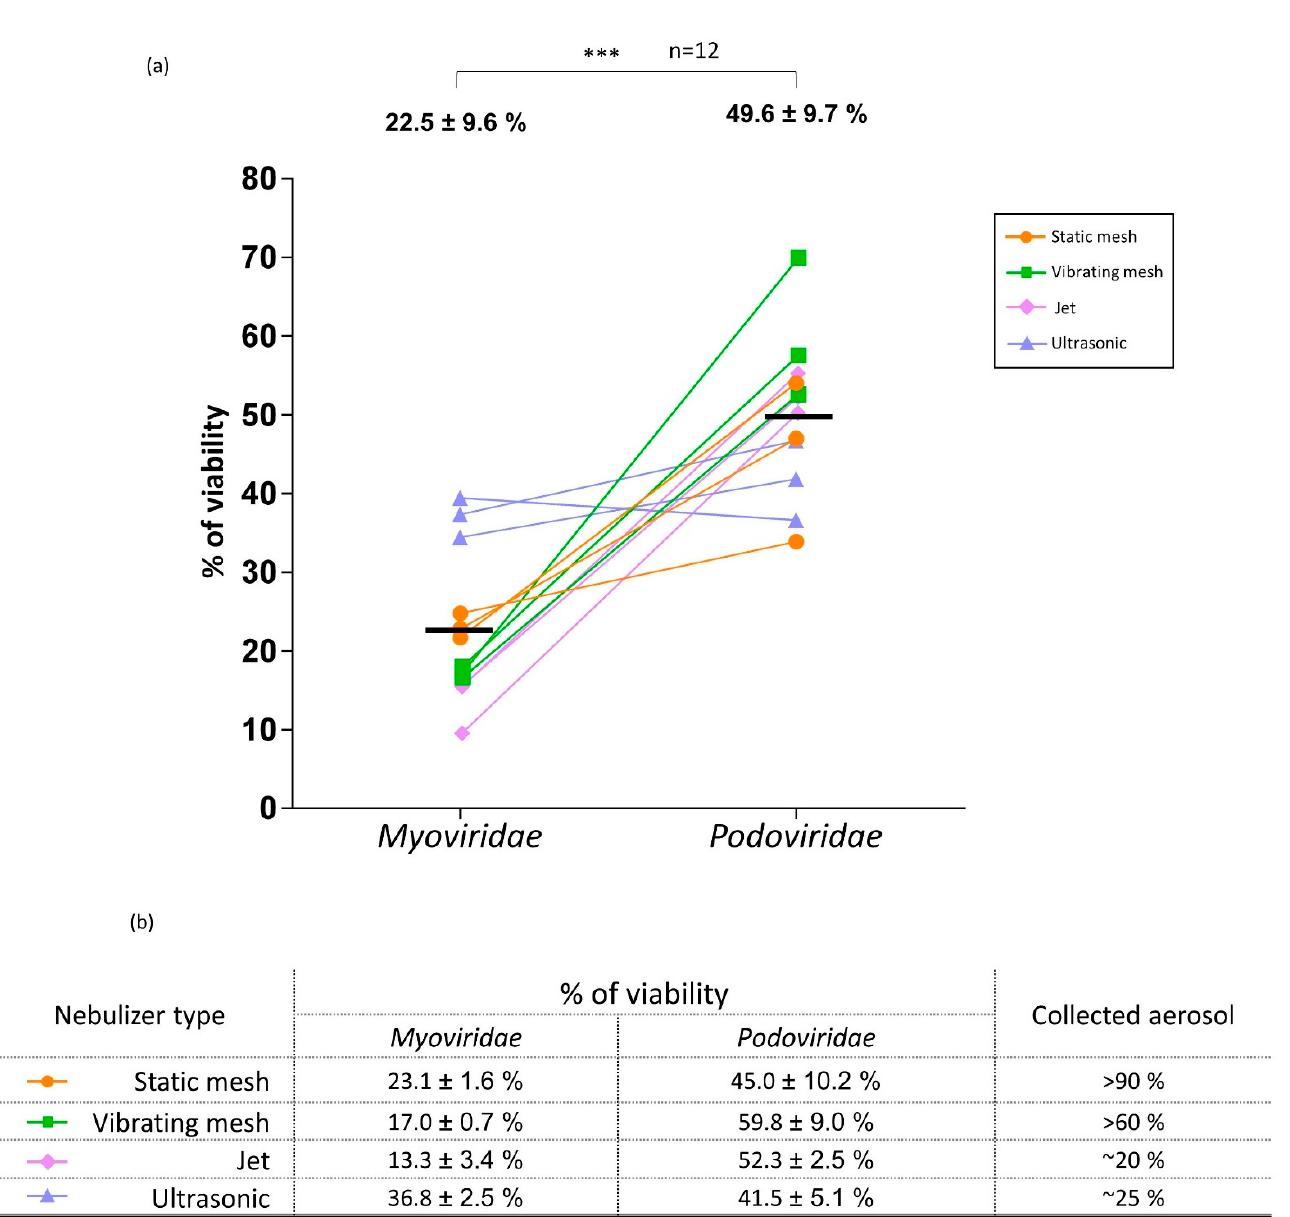
Figure 5. Nebulization effect on phage viability depending on the morphotype. ( a ) Percentages of viability of Myoviridae and Podoviridae after nebulization with different types of nebulizers. Each type of nebulizer is identified by a color. Mean% ± SD of viabilities obtained for each morphotype is indicated at the top of the dot plot and *** = p < 0.001 ( t -test, n = 12). Horizontal bar indicated the mean value ( n = 12). ( b ) Mean% ± SD of viability of Myoviridae and Podoviridae obtained for each type of nebulizer. Collected aerosol corresponds to the quantity of aerosol recovered in the BioSampler ® using Na+ as a tracer and expressed in % of the initial dose.